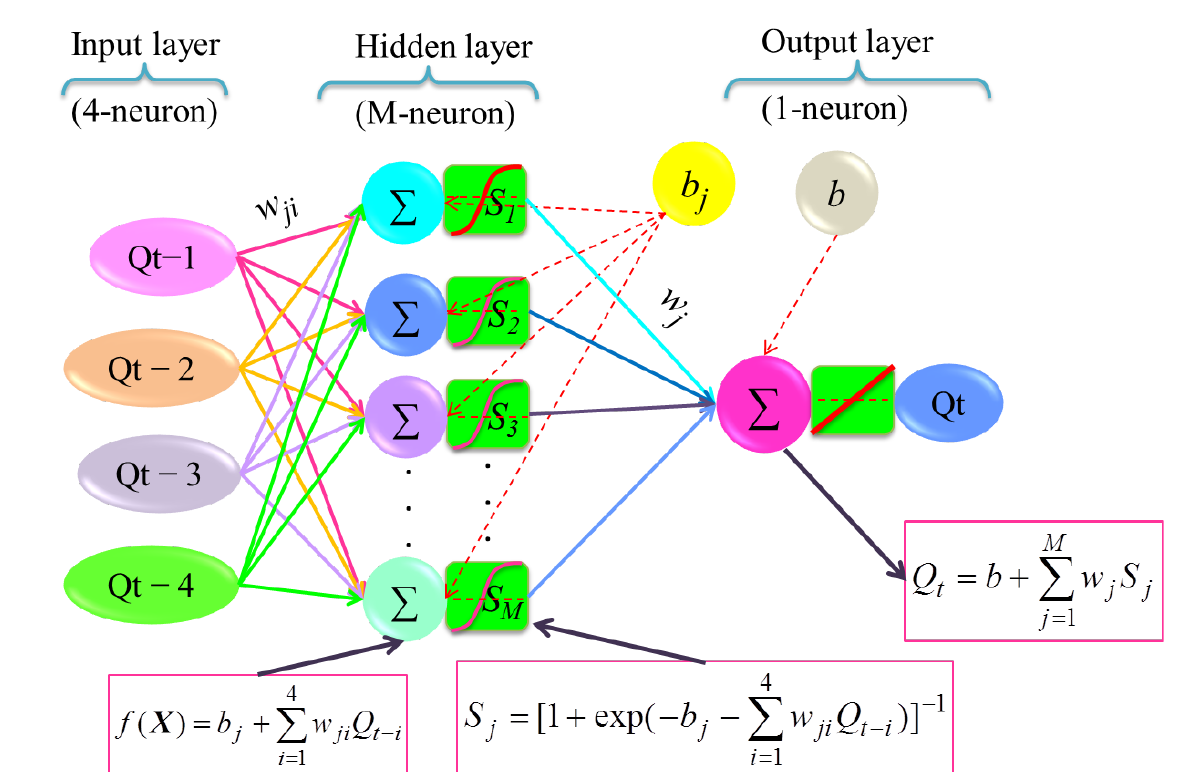
Figure 2. Structure of MLPNN for forecasting Qt .